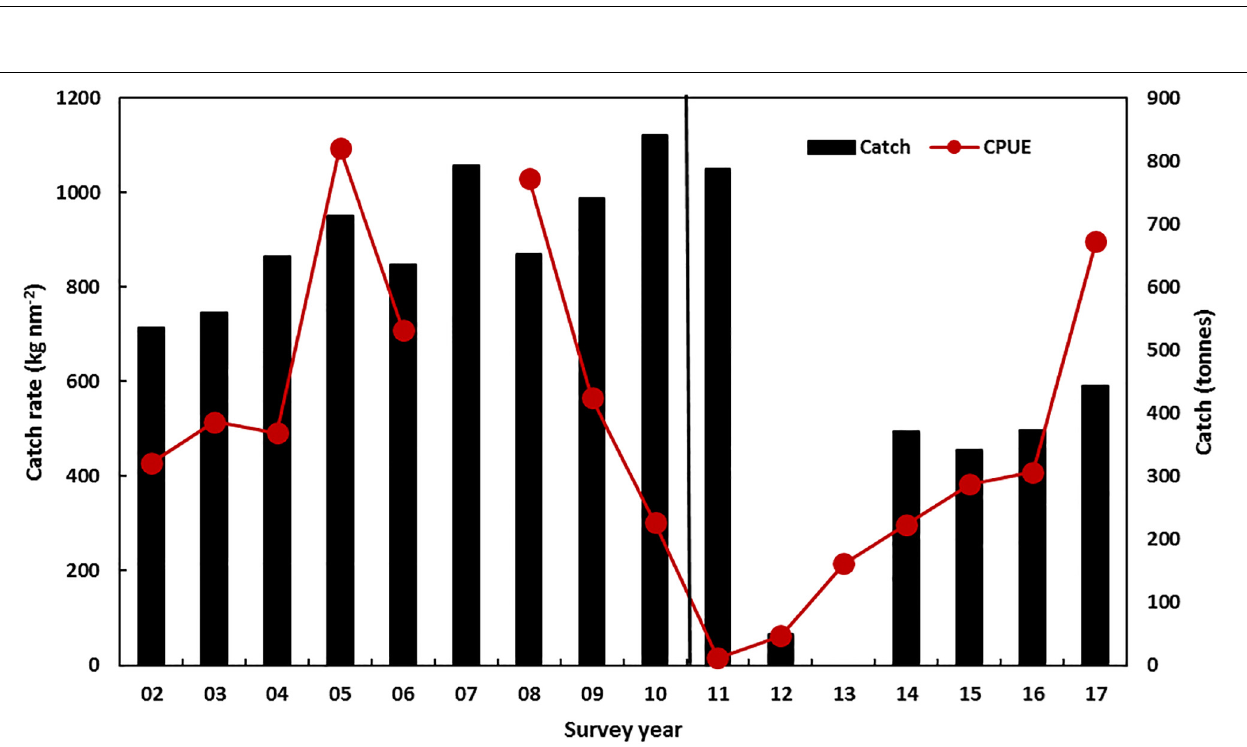
FIGURE 6 | November trawl survey standardized mean catch rate of legal-size blue swimmer crabs and the catch (t, vertical bars) in Shark Bay. No survey information was collected in 2007. The vertical line indicates the occurrence of the heatwave.